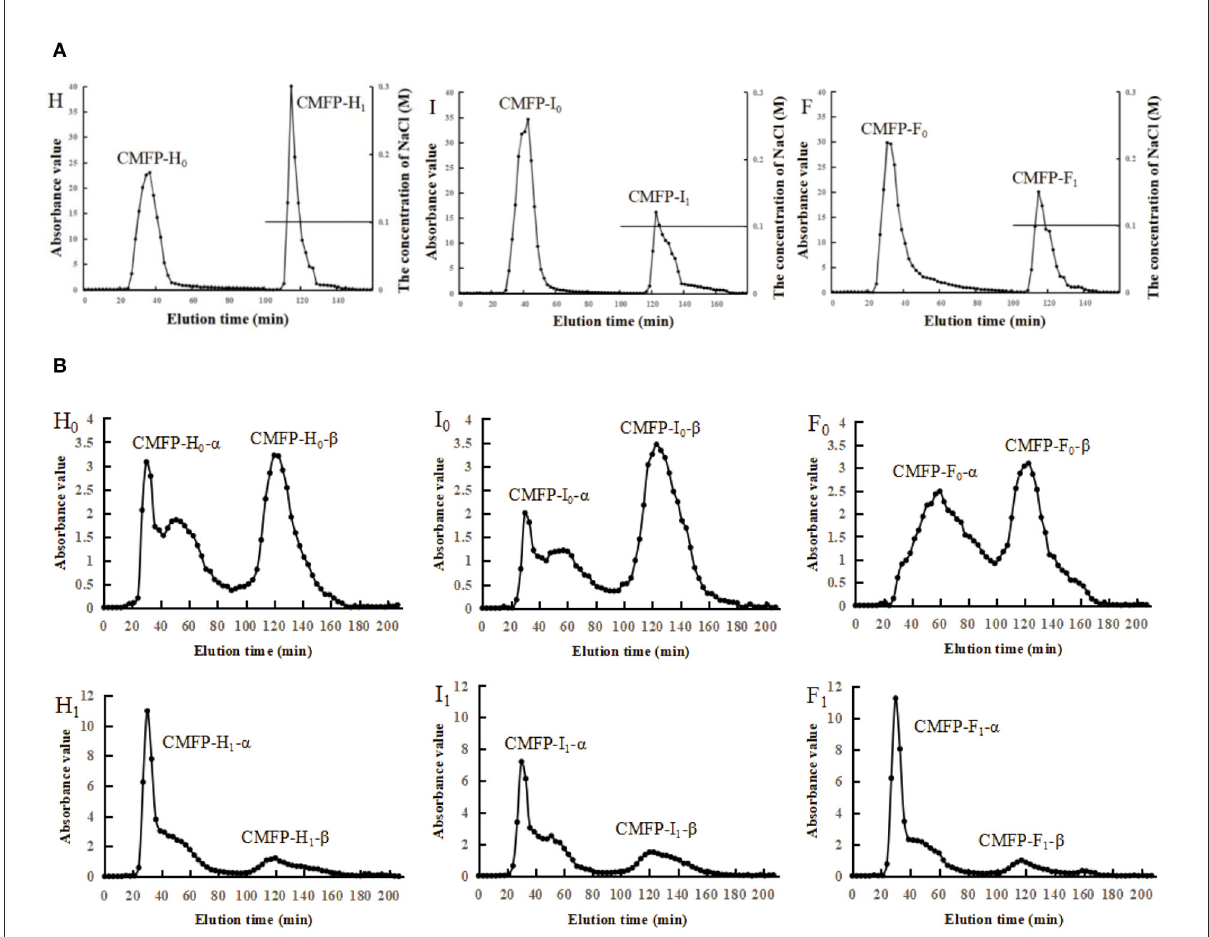
FIGURE2 Elution curve of DEAE-52 and Sephacryl S-400 for CMFPs. (A) Elution curve of DEAE-52 of CMFPs. (B) Elution curve of Sephacryl S-400 of CMFPs. (H) CMFP-H. (I) CMFP-I. (F) CMFP-F. (H 0 ) CMFP-H 0 . (I 0 ) CMFP-I 0 . (F 0 ) CMFP-F 0 . (H 1 ) CMFP-H 1 . (I 1 ) CMFP-I 1 . (F 1 ) CMFP-F 1